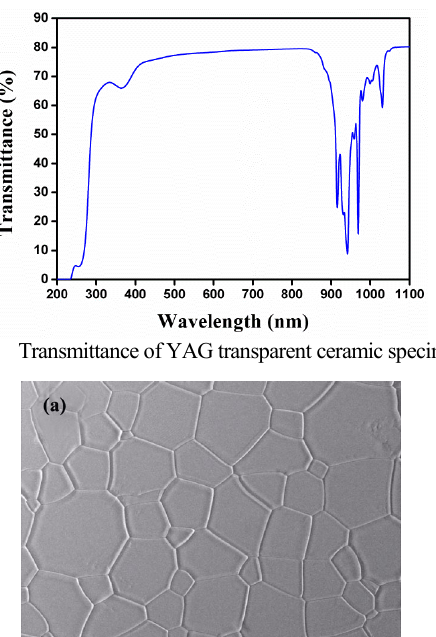
Fig. 3 XRD patterns of YAG powders and transparent ceramic samples.